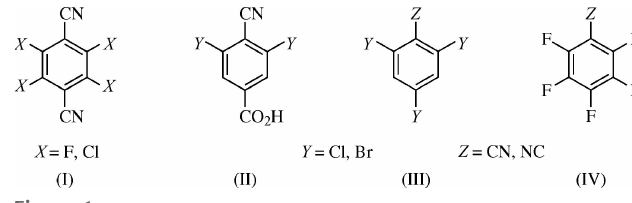
Figure 1 Contextual